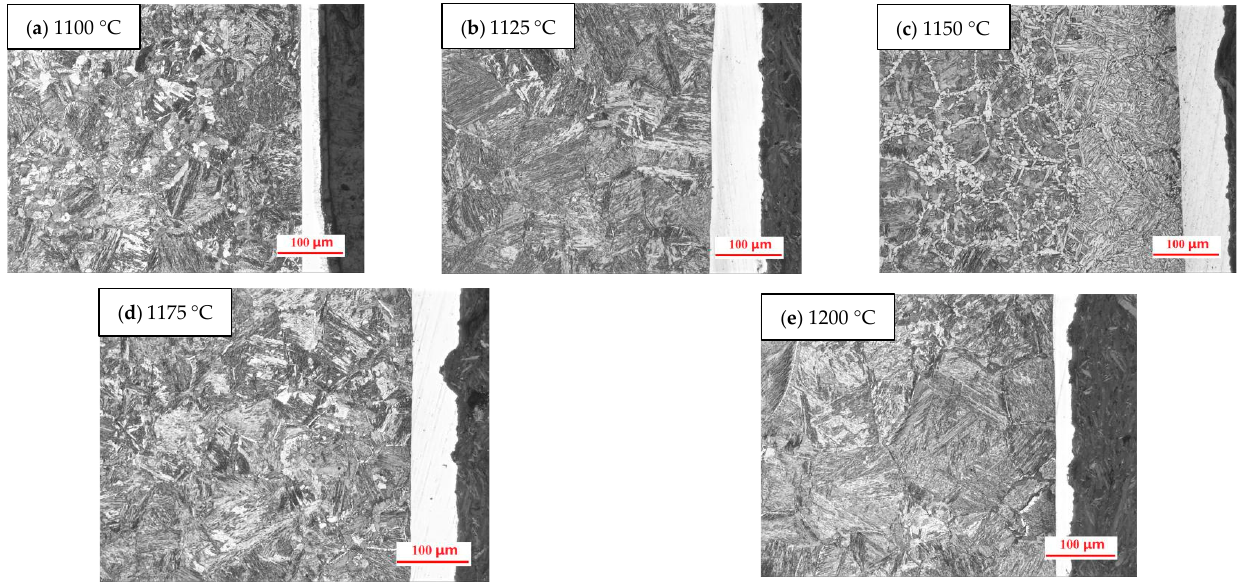
Figure 2. The microstructures of the Cu–steel interface with hot-dipping time of 60 s under differ- ent